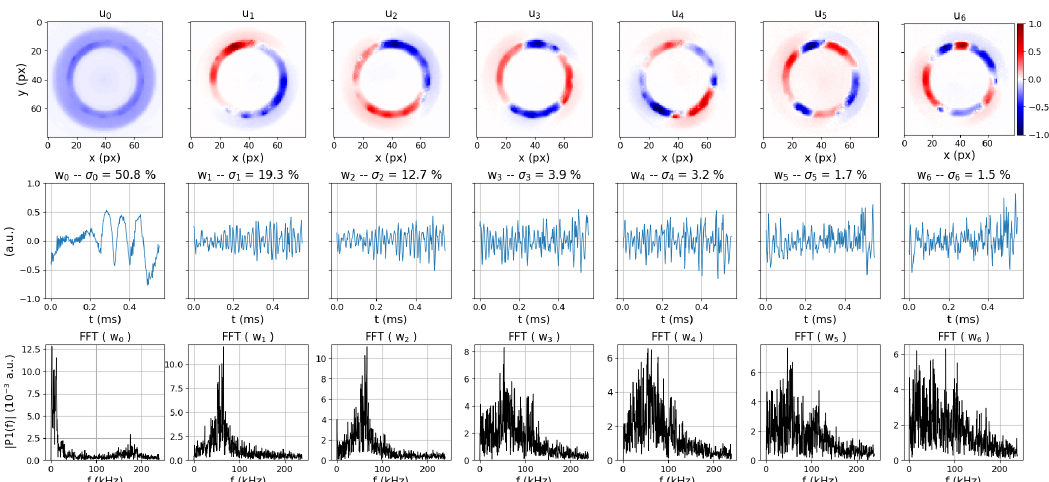
Figure 5. Nominal regime : POD analysis of the front videos with a discharge voltage U d = 200 V, a mass flow rate Q = 1.8 mg · s − 1 , a cathode heating current I H = 20.05 A ( I H / I H , crit = 1.09) and a acquisition frequency of F fps = 480 kfps. (Top) Spatial POD modes u i ; (Middle) corresponding temporal POD modes w i with their singular value λ i given as σ i = λ 2 over the sum of all the λ i expressed as a i percentage; and (Bottom) corresponding FFT.